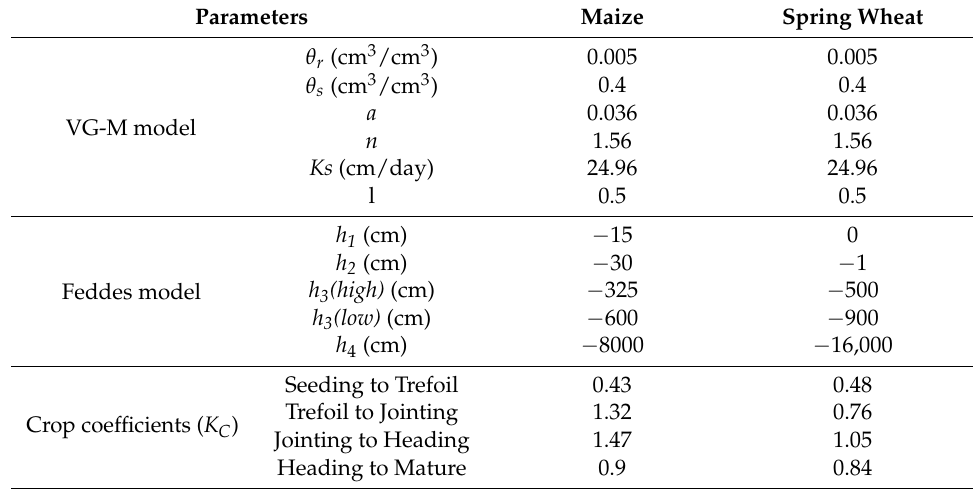
Table 4. Parameters for